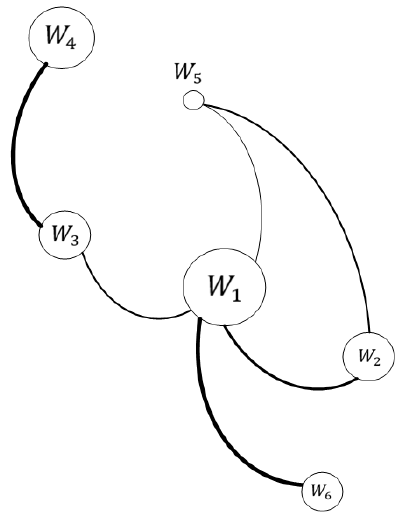
Figure 3. The structure of the constructed social semantic network.